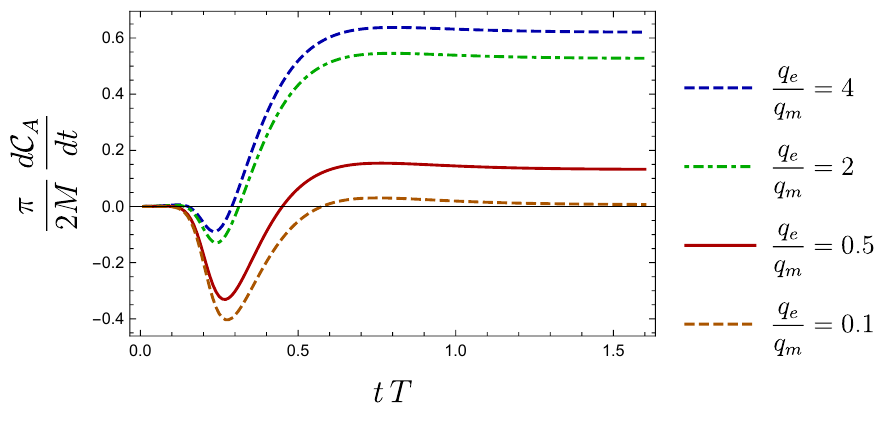
Figure 2 . The rate of change of complexity for the dyonic black hole given by eq. (2.7), with r (cid:0) = 0 : 3 r + , L = 0 : 5 r + and ‘ = L . We (cid:12)x the parameters that determine the geometry, but vary ct the ratio between electric and magnetic charges. As predicted by eq. (2.22), when the charge is mostly magnetic, the growth rate of complexity approaches zero at late times. The limit q m ! 0 essentially matches the top curve for (cid:31) = 10. Similarly the q e ! 0 and the (cid:31) = 0 : 1 curves are indistinguishable on this